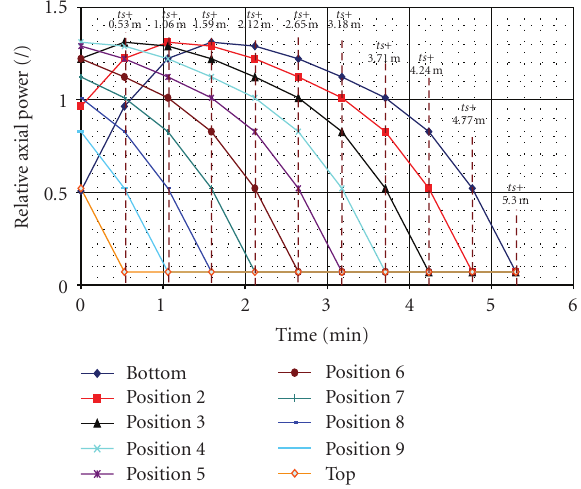
Figure 5: Relative axial power history during refueling as a function of time for di ff erent axial position fuel rod extraction.